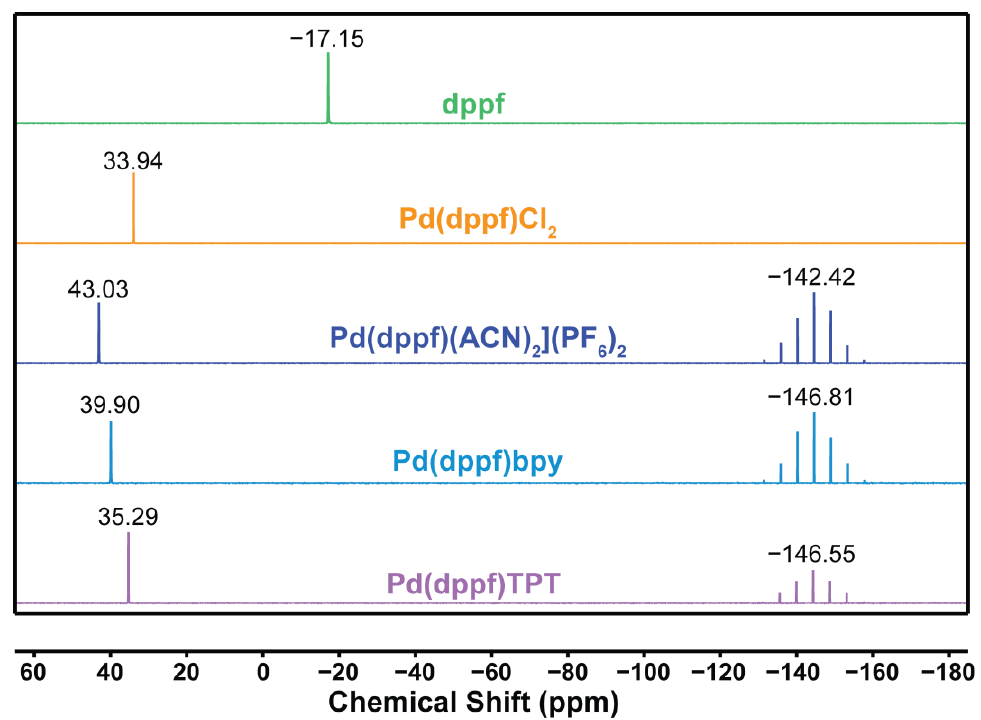
(Figure S3 in Supporting Information), downfield from the peak from ACN at 1.94 ppm, is evidence of a coordinated solvent and supports the formation of the cis-ACN product.